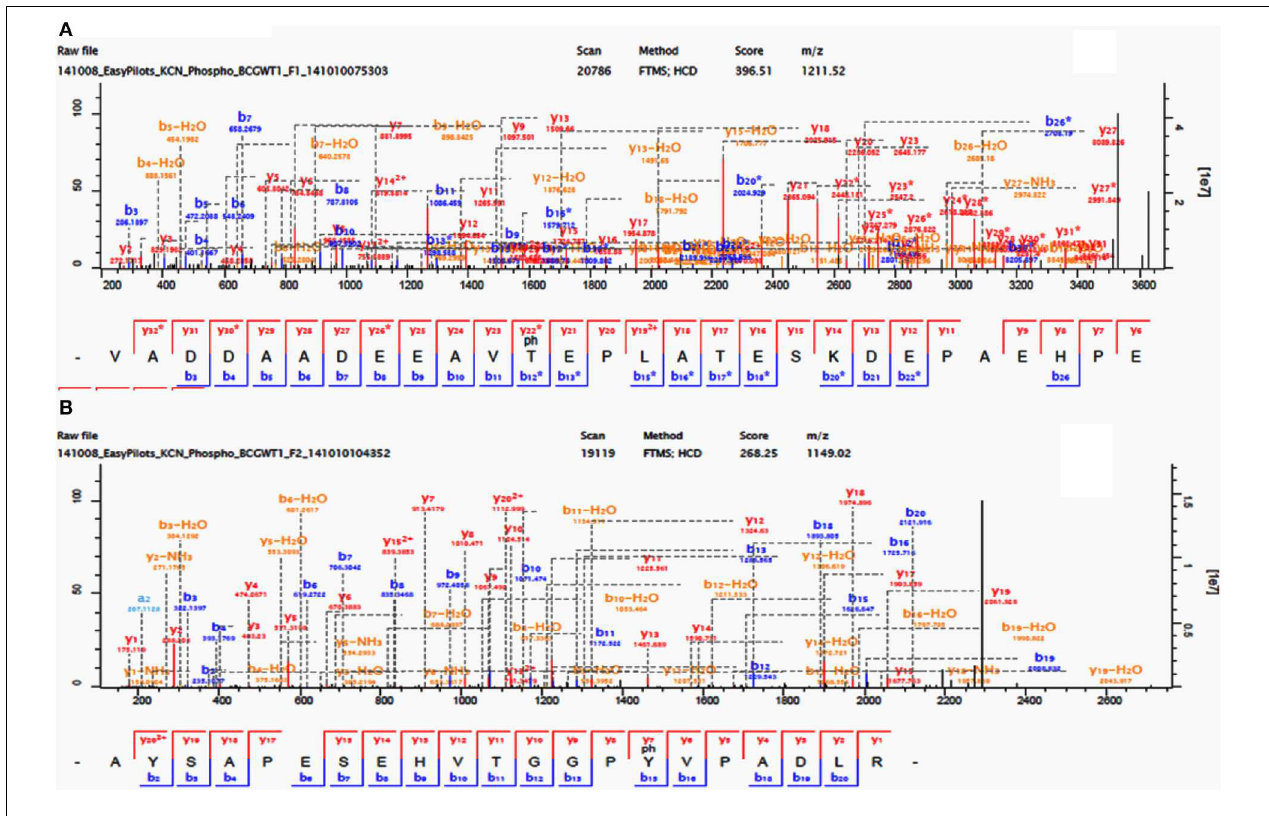
FIGURE 1 | Phosphorylation of M. bovis BCG Cell division FtsQ (Thr 24 ) and probable conserved protein membrane mmpS3 (Tyr 70 ). (A) Identification of phosphorylated residue by mass spectrometry.